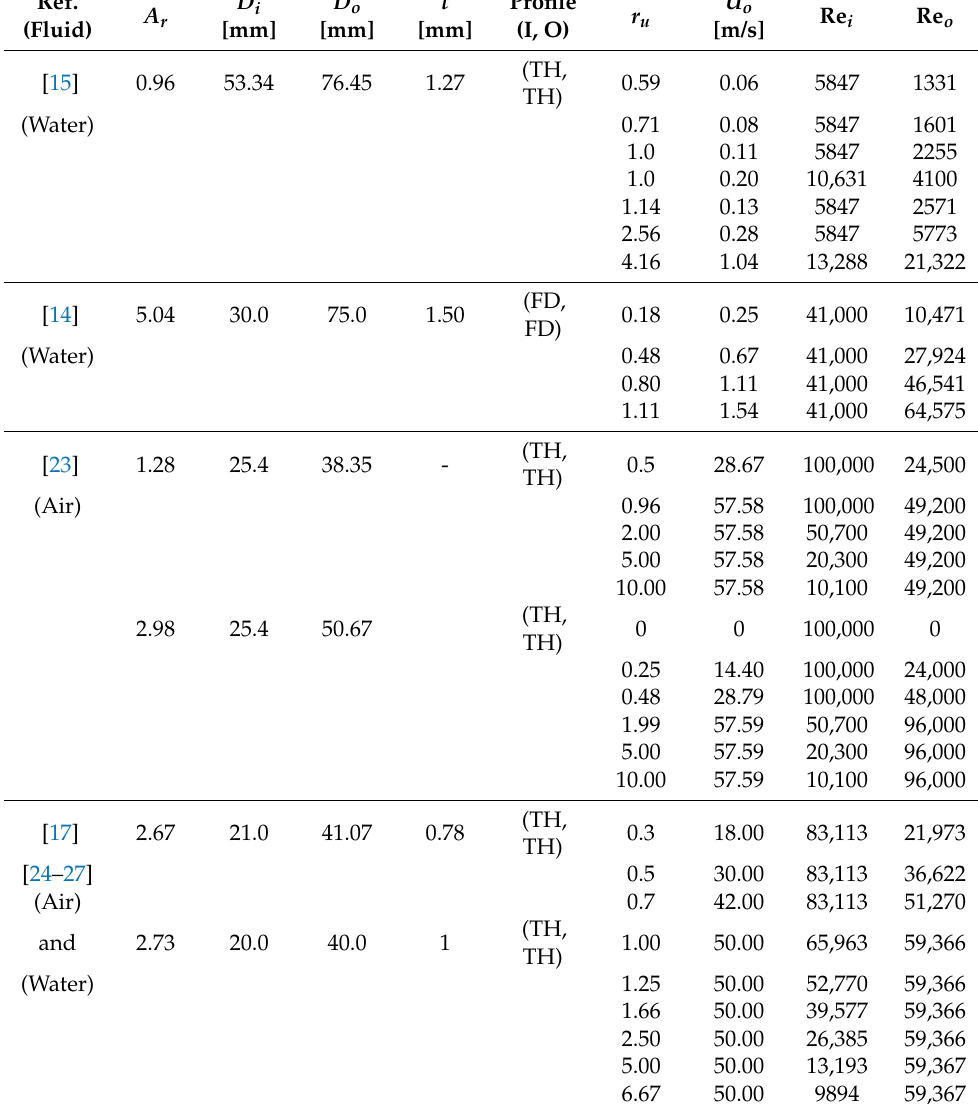
Table 1. Overview of relevant literature publications on coaxial jets ( t and “FD” denote “Top hat” (uniform) and “Fully developed turbulent pipe flow” jet exit profiles, respectively. “I” and “O” denote “inner” and “outer” jet,